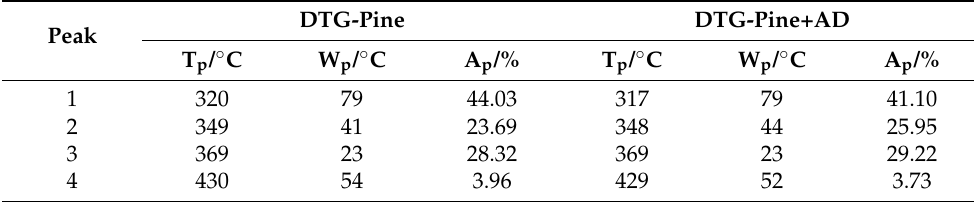
Table 2. Fitting results of the DTG curve.